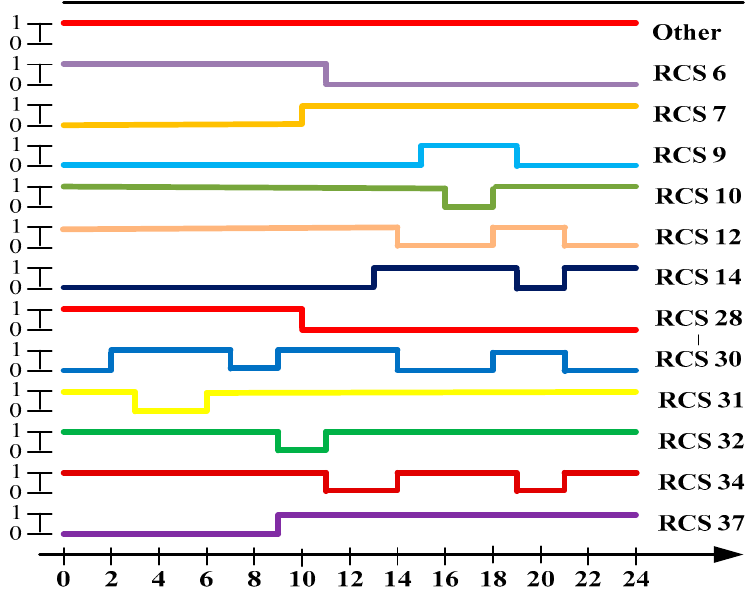
Figure 11. Status of RCSs through the hourly reconfiguration process in CS5. Energies 2018 , 11 , x FOR PEER REVIEW